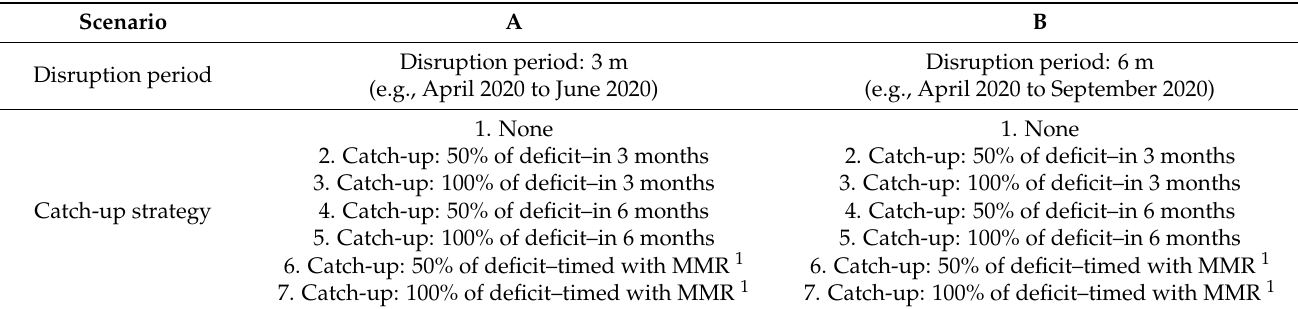
Table 1. Summary of the disruption scenarios ranging in duration, timing, and magnitude of the